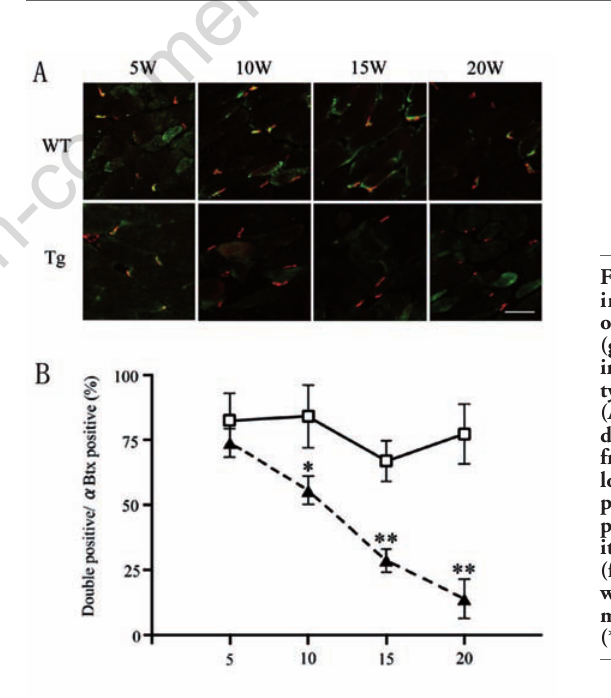
Figure 2. HE staining of soleus muscles in wild-type (WT) and Tg mice. Note a subtle change in 10 weeks of Tg mice, with deteriorating 15-20 weeks of age.